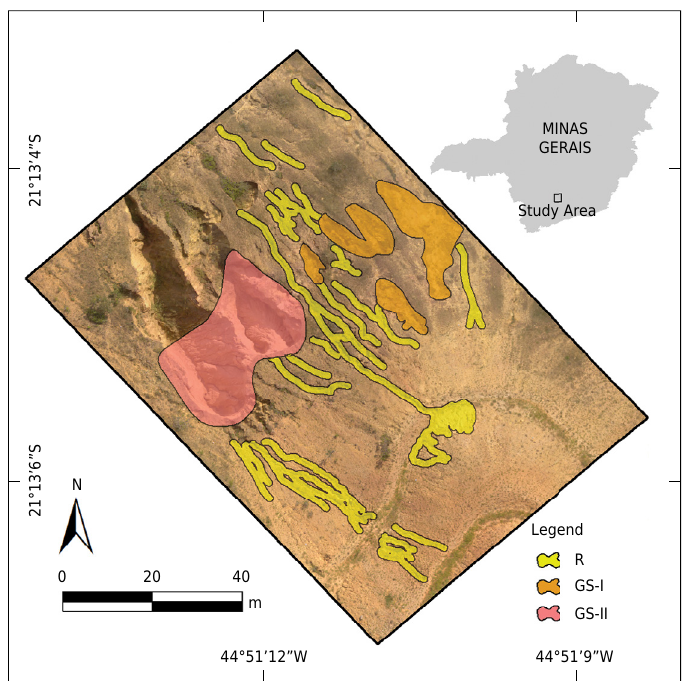
Figure 1. Location of the study area and the analysed segments in Itumirim, Minas Gerais, Brazil. R: deep rills; GS-I: small gullies; and GS-II: large